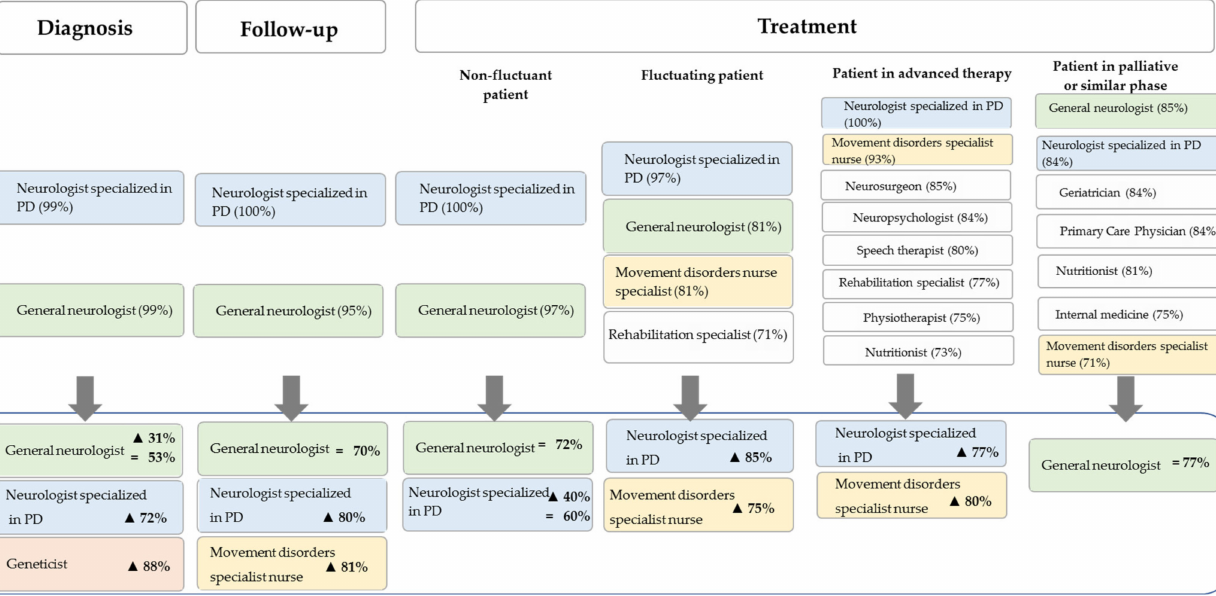
Figure 1. Relevance of medical specialties: present and future. For the current situation, percentages of panelists who considered a given specialty “Relevant” or “Very relevant” in each stage are shown. For the trend by 2030, percentages of panelists who predicted a decrease ( (cid:72) ), no change (=) or an increase ( (cid:78) ) for the relevance of each specialty in each stage are